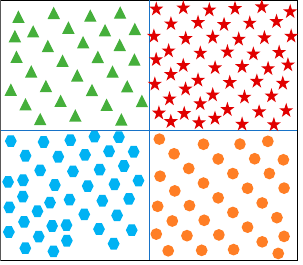
Figure 5. A partition with 𝑛 = 154 and 𝑘 = 4 [35].